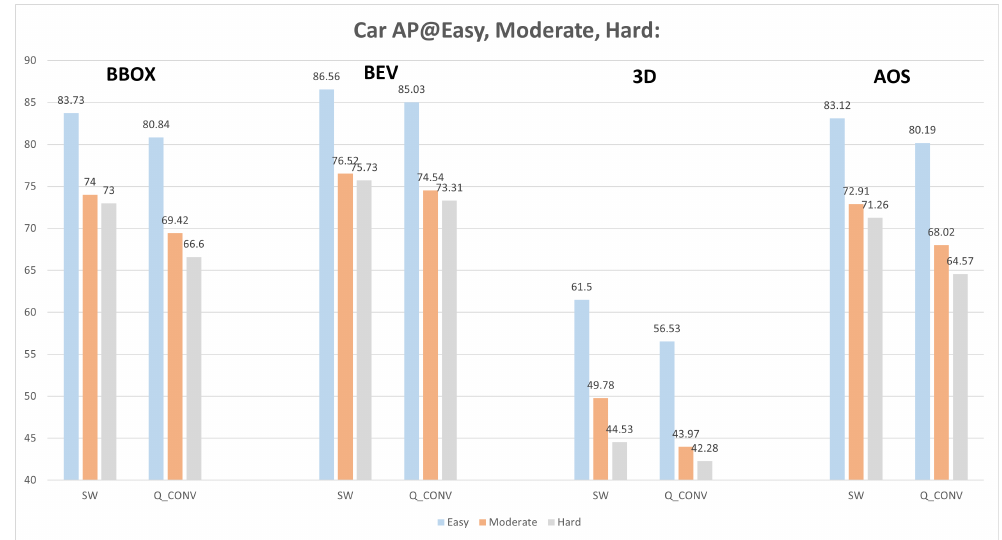
Figure 15. Evaluation between SW-only version and quantized model, with BBOX, BEV, 3D, and AOS metrics for easy, moderate, and hard difficulty levels.